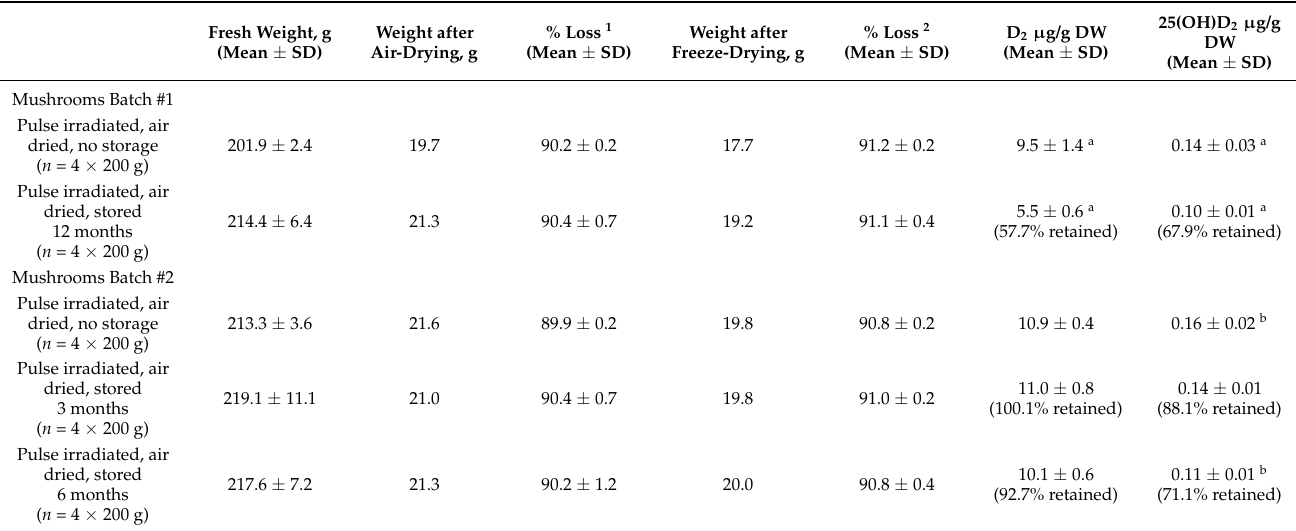
Table 1. Retention of D vitamers in stored UV-irradiated, air-dried